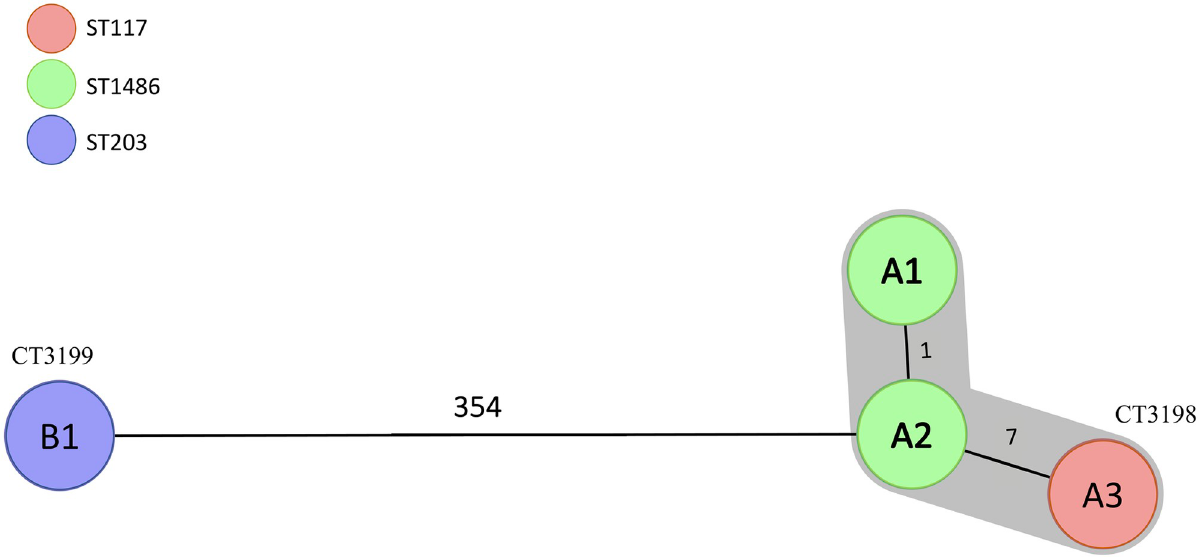
Fig 1. Minimum spanning tree based on the cgMLST typing of the Norwegian VanD VRE fm . Regardless of the different STs, A1-3 strains clustered together while the VRE fm strain B1 showed 354 allelic differences with the A2 strain.